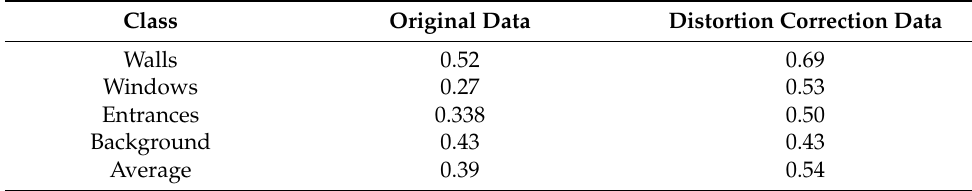
Table 11. mIoU of original and distortion correction data.